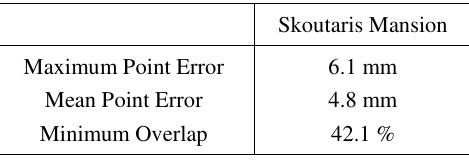
Table 1. Scan Point Statistics.